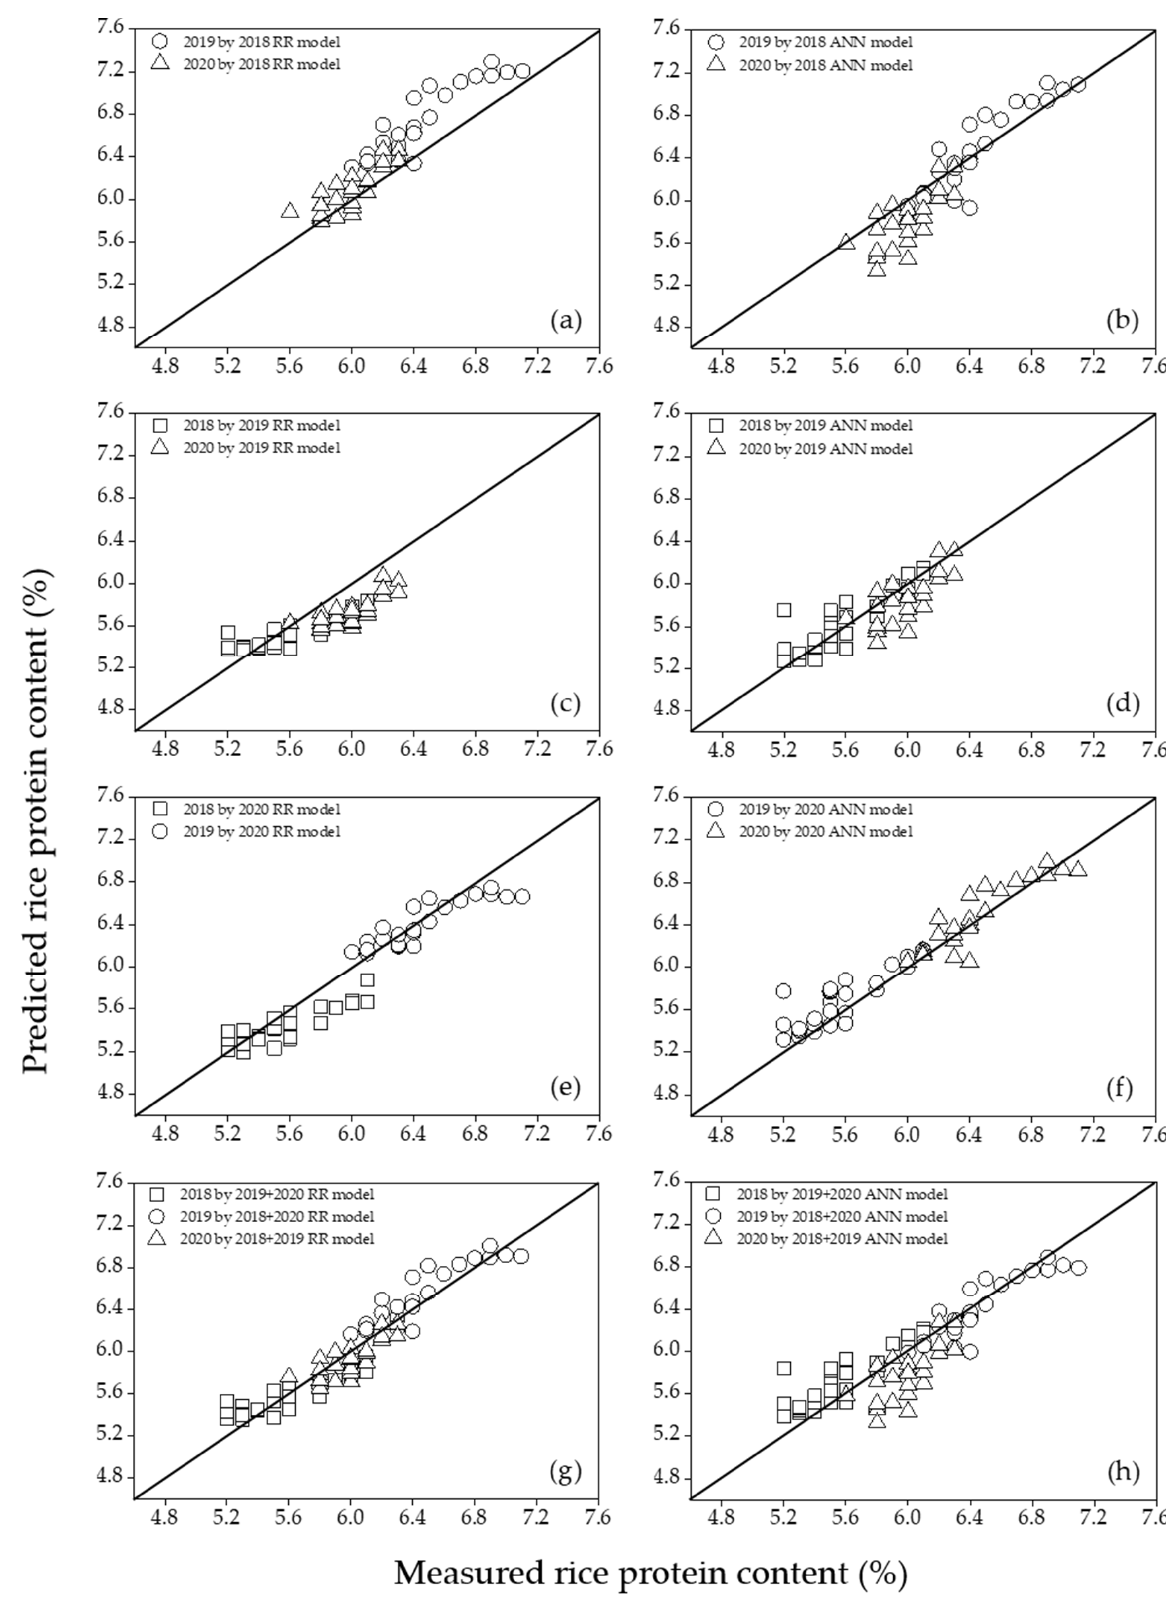
Figure 5. Mutual predictions of the RR models ( a , c , e , g ) and the ANN models ( b , d , f , h ) of rice-protein content in single- and multi-year analyses.